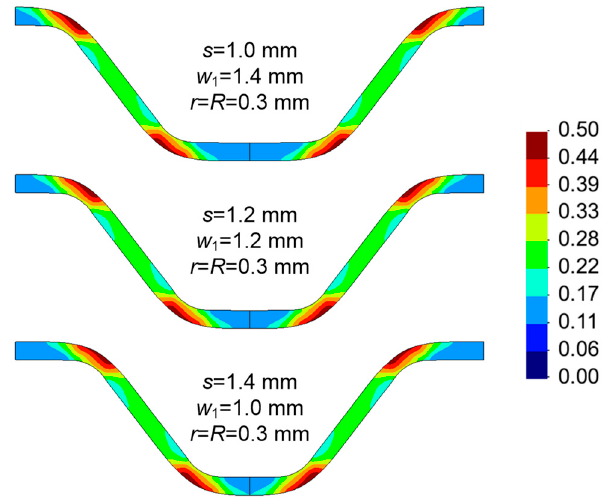
Figure 15. Equivalent plastic strain distribution plotted on the deformed configuration of the channel for three different values of channel width and rib width (plane strain conditions) and h = 1.0 mm.